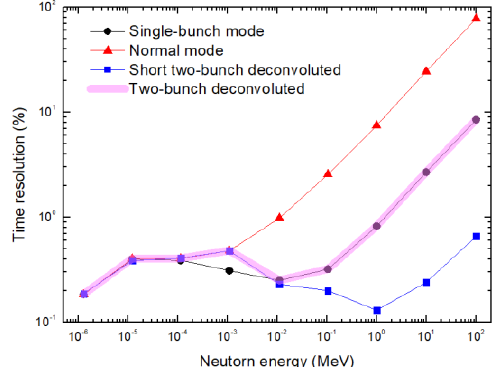
Fig.3 Time resolution with respect to neutron energy for the different operation modes (at 77 m from the